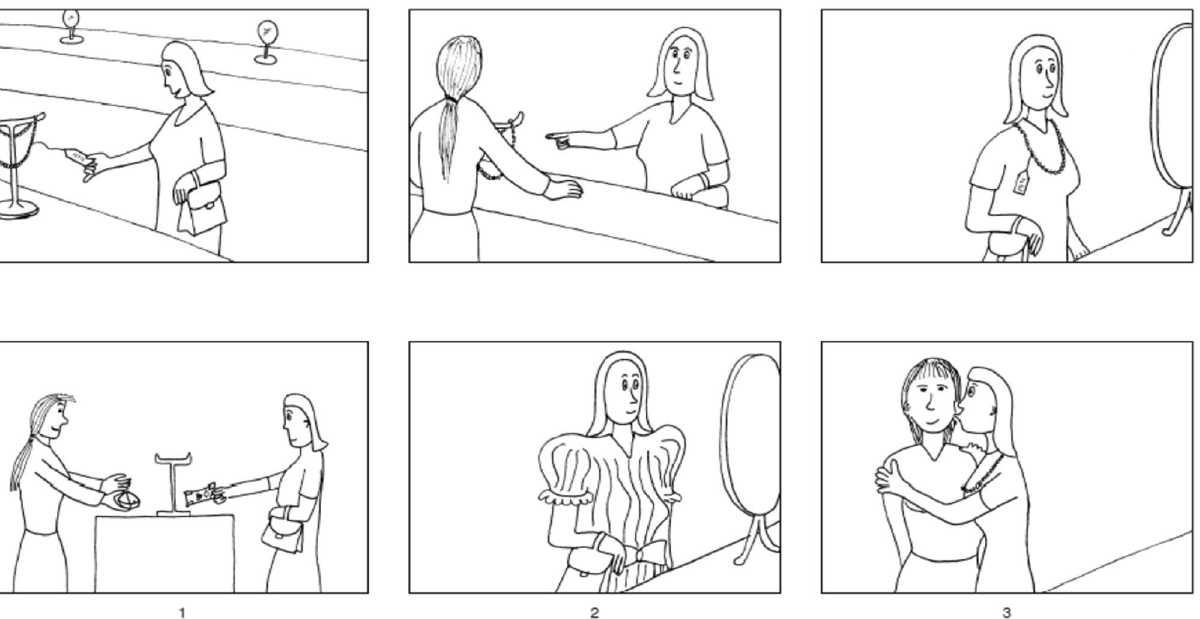
Figure 2. V comics: this test was used to assess inference-based aspects of mentalizing. In this task, participants are required to infer a character’s intention, or to make inferences based on physical causality. (From Ehrle et al. et Baron Cohen et